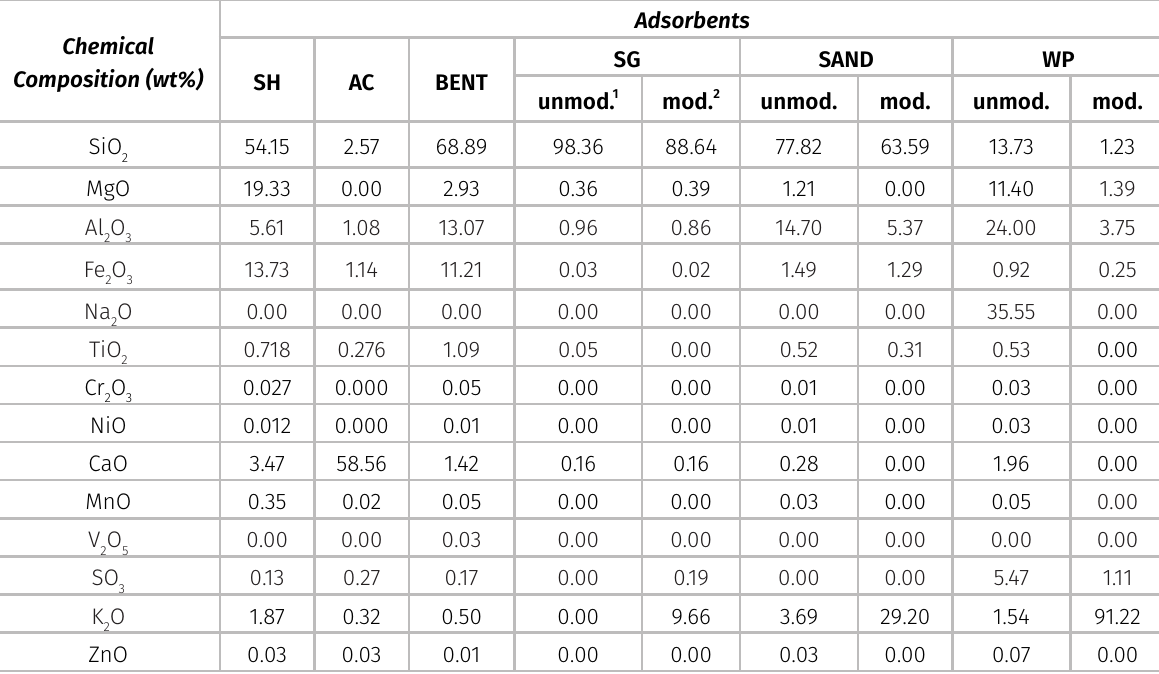
Table II. Chemical characterization of adsorbents obtained by X-ray fluorescence (XRF).